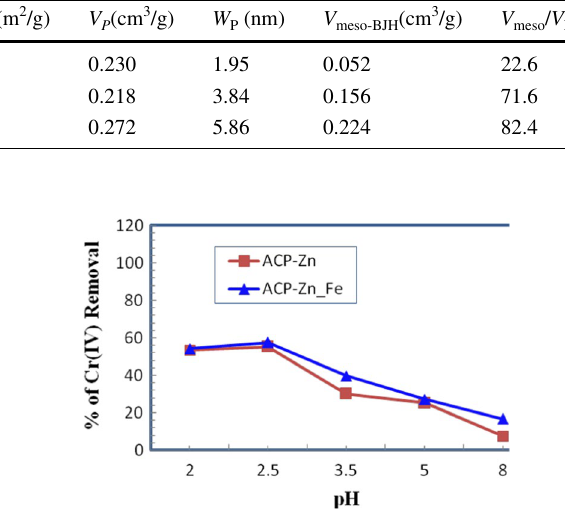
Fig. 4 Effect of pH on Cr (VI) removal using 0.5 g/L of ACP-Zn